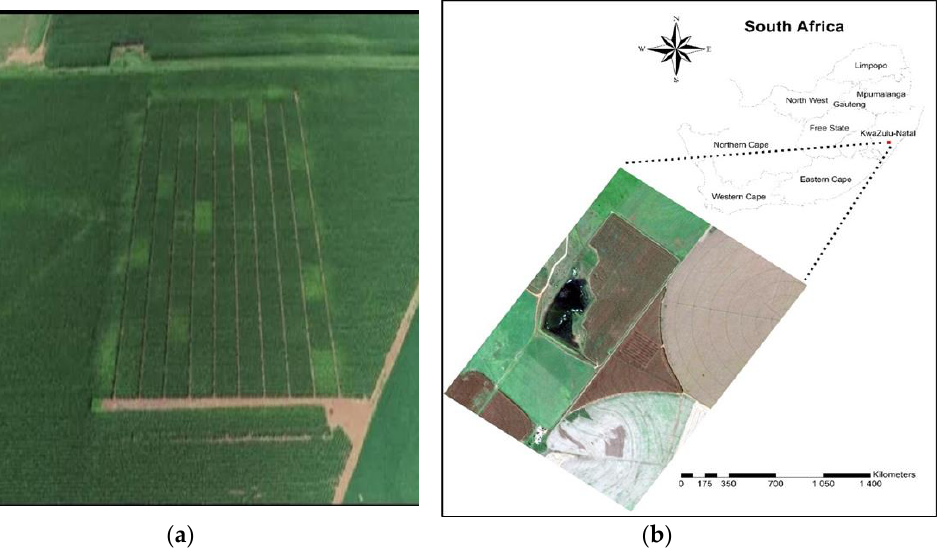
Figure 1. The location of the study area (28°55 ’ 26.83 ” S, 29°33 ’ 38.64 ” E, 1038 m above sea level), where ( a ) & ( b ) shows the aerial view at different scales. Table 1. Average temperature and total rainfall received between April 2019 and March 2020.